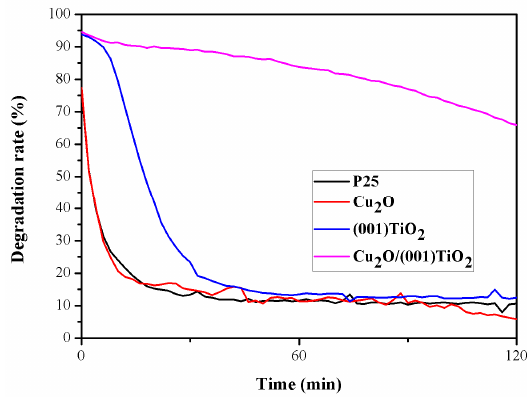
Figure 11. Degradation of ammonia by different catalysts.